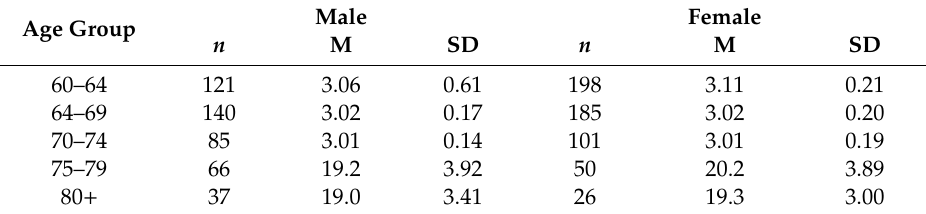
Table 5. BMI based on age group and gender after log transformation, Unit: kg / m 2